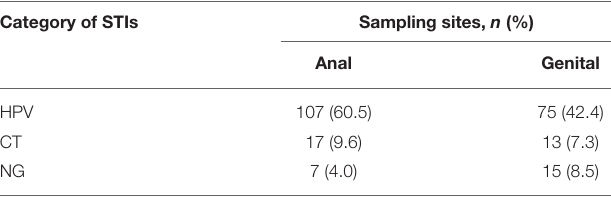
TABLE 2 | The prevalence of HPV, CT, and NG stratified by sampling sites among 177 MSM. Category of